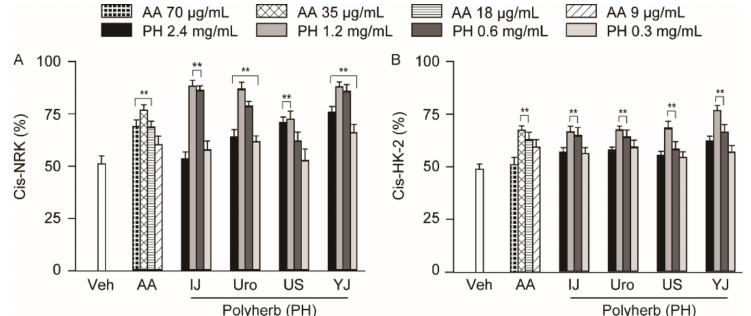
Figure 2. Protective e ff ects on cisplatin-induced cell injuries. Renal cell injury was induced by cisplatin in normal rat kidney (Cis-NRK, ( A )) and human kidney-2 (Cis-HK-2, ( B )) cells. The cells were treated with AA, Injinhotang (IJ), UrofenTM (Uro), Ucha-Shinki-Hwan (US), or Yukmijihwang-tang (YJ) at the indicated doses for 3 days. The results are expressed as a percentage of the cell viability in the cisplatin non-treated normal control. Values are means ± SD from three independent experiments. **: p < 0.01 versus the vehicle group